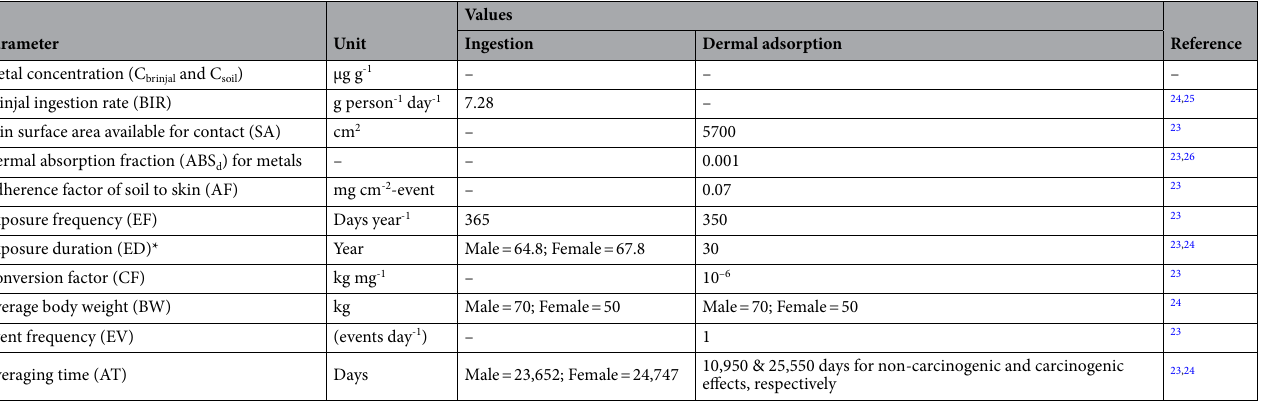
Table 2. Input assumptions used to calculate non-carcinogenic human health risk due to different trace metal exposures through dietary intake of brinjal and dermal adsorption of soils. *ED is calculated by deducing the childhood period of 6 years from the total life